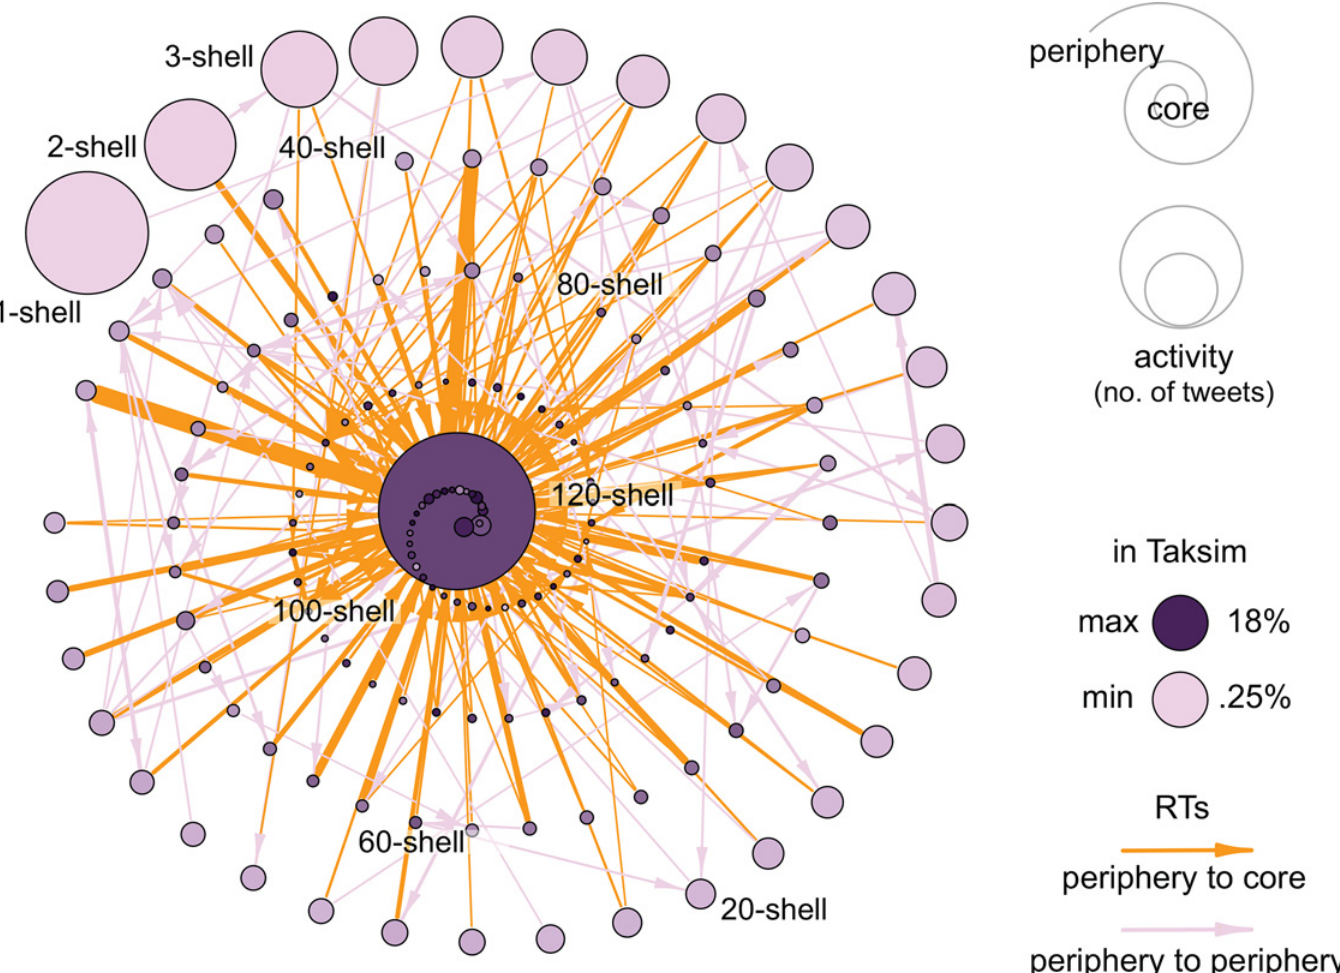
Fig 3. K -core decomposition of the network of retweets that emerged during the 2013 Taksim Gezi Park protests in Turkey (see S1 Text). Participants have been grouped in their corresponding k -shells, here represented by nodes. Lower k- shells contain participants at the periphery of the network; higher k -shells contain core participants. Node size is proportional to aggregated activity, measured as total number of protest messages (not just retweets). Arcs indicate retweeting activity, and their width is proportional to normalized strength (arcs with lower strength have been filtered to improve the visualization of the network). The darkness of nodes is proportional to the percentage of participants who reported being in the Taksim Gezi Park (the geographical epicenter of the protests), as indicated by the geographic information attached to their tweets. Most of these participants are at the core of the network where most RTs are also sourced from, thus allowing information to flow from the core to the